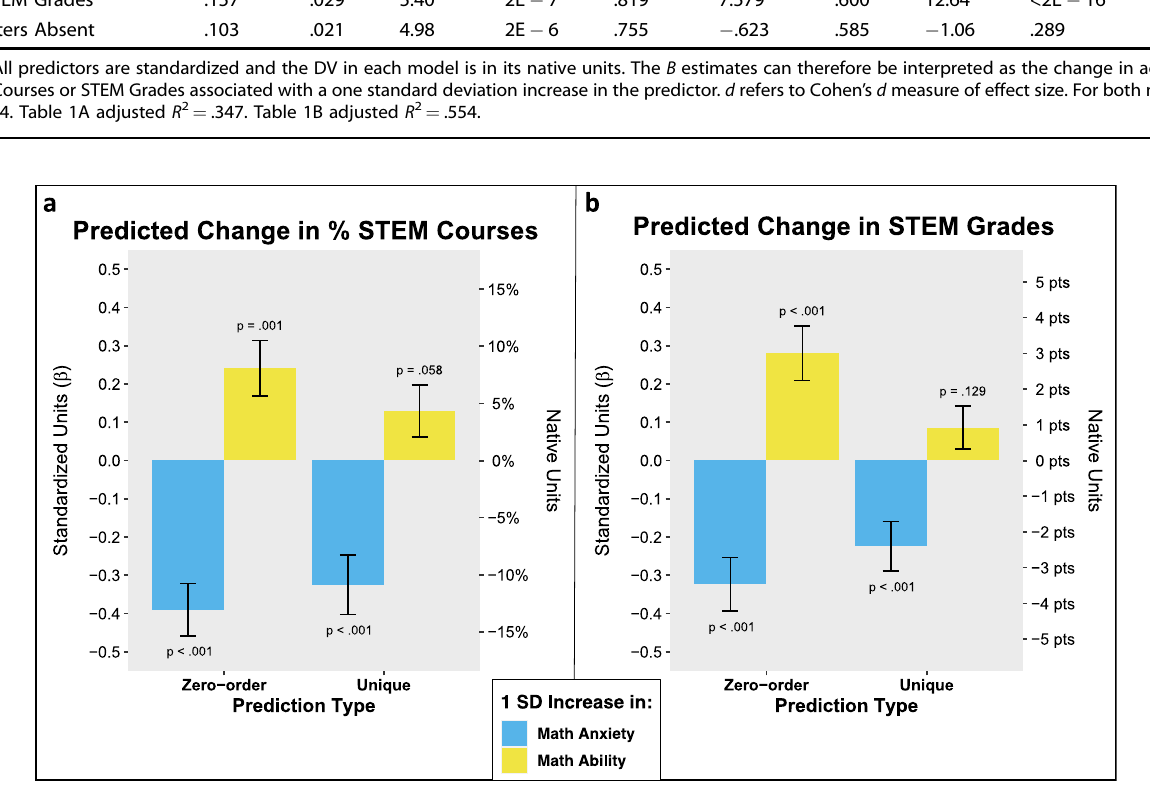
Table 1. The key results of these models are visualized in Fig. 1. The results displayed in Fig. 1a show that both Math Anxiety and Math Ability signi fi cantly predicted % STEM Courses when no